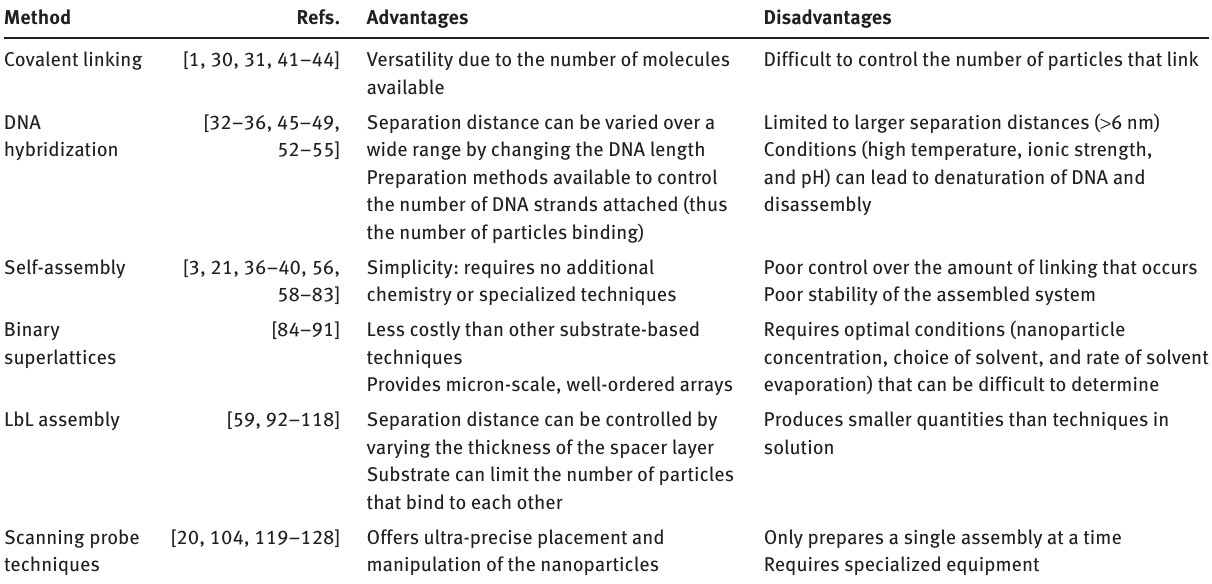
Table 1: Summary of plasmon-exciton nanoparticle assembly methods.